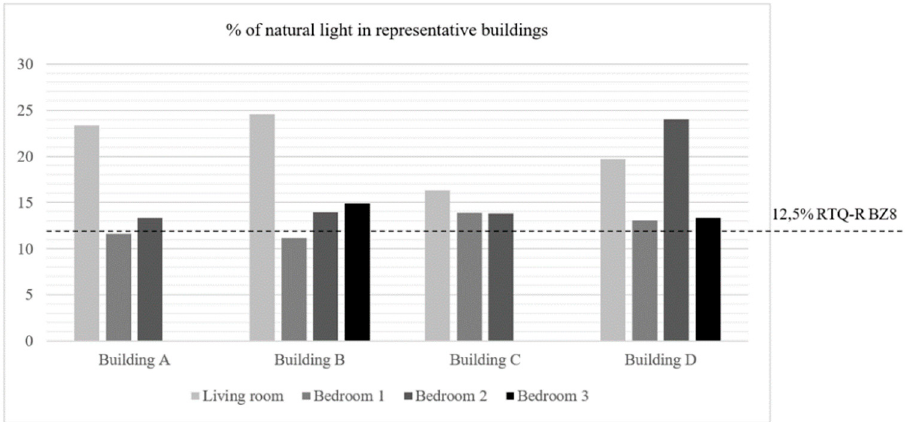
Figure 5. Percentage of natural light in the extended-use spaces (EUSs) of the representative buildings.